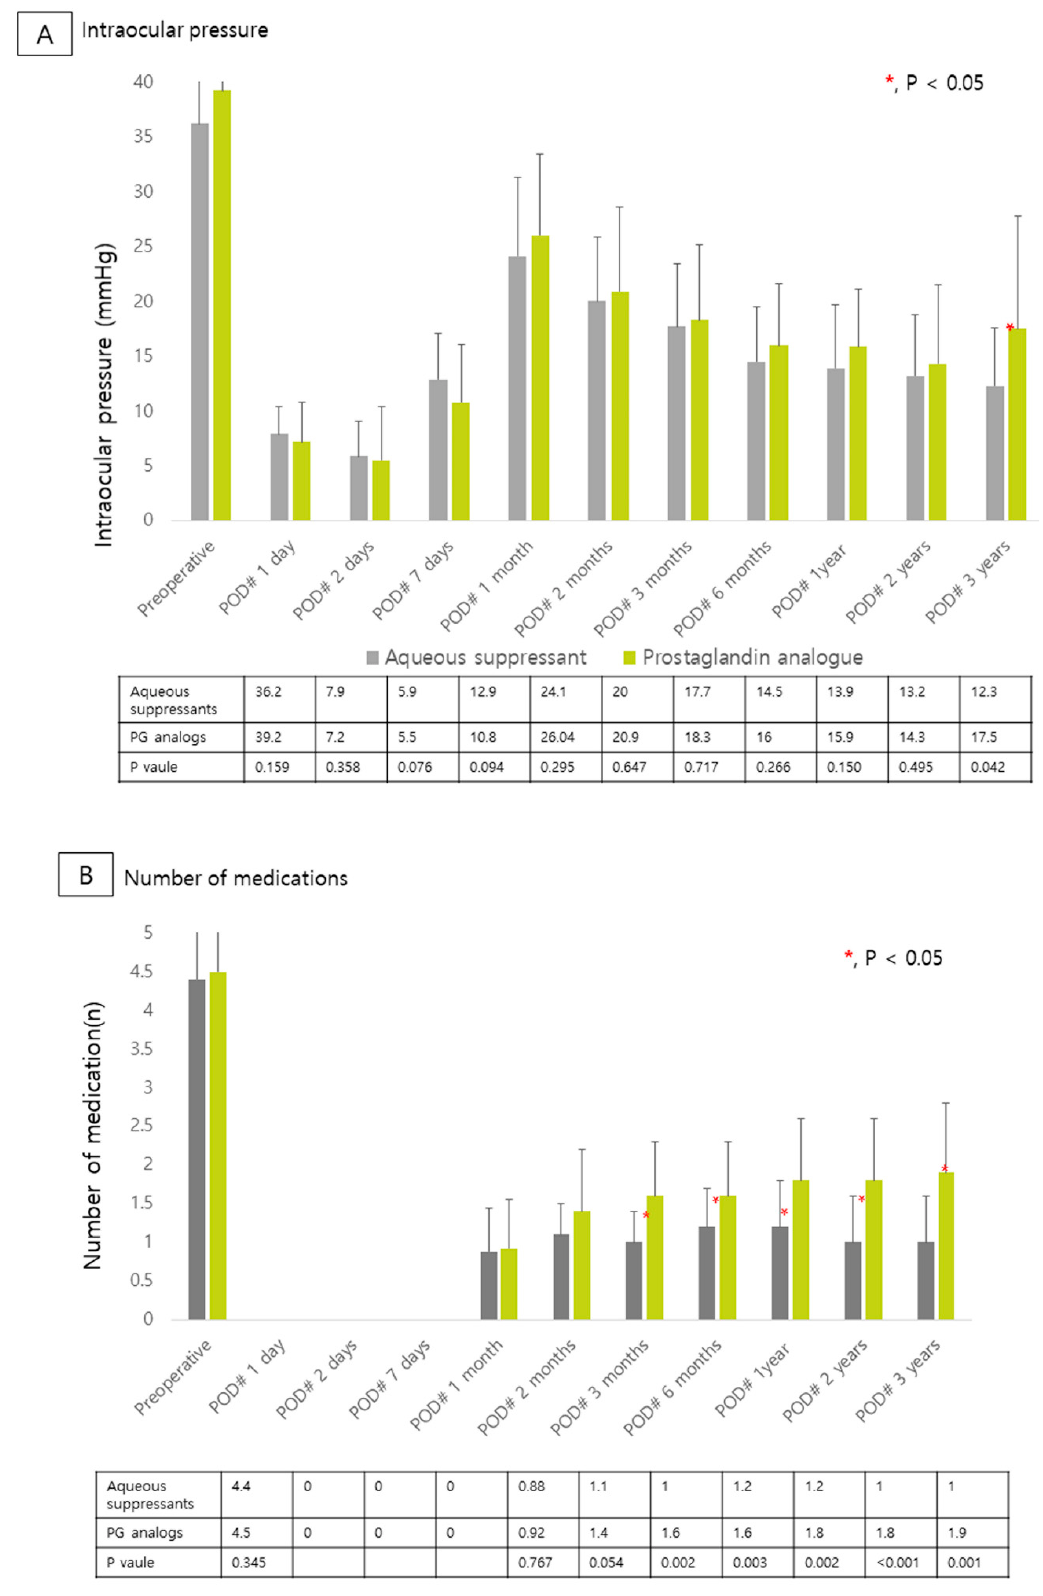
Figure 1. Postoperative intraocular pressure (IOP) and number of medications during follow-up changes in IOP ( A ), and number of medications ( B ) before and after the Ahmed valve implantatio. POD, postoperative